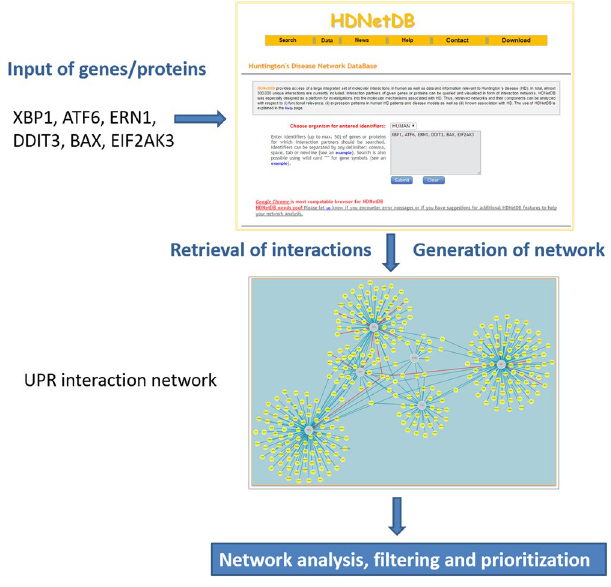
Figure 2. HDNetDB workflow. HDNetDB retrieves the physical and regulatory interactions found for the queried genes or proteins, and generates a network. This is visualized by larger grey and smaller yellow nodes representing the input/query and interacting proteins, while red arrows and blue edges represent regulatory and protein-protein interactions, respectively. Subsequently, the network can be examined and filtered using various complementary datasets and tools integrated in